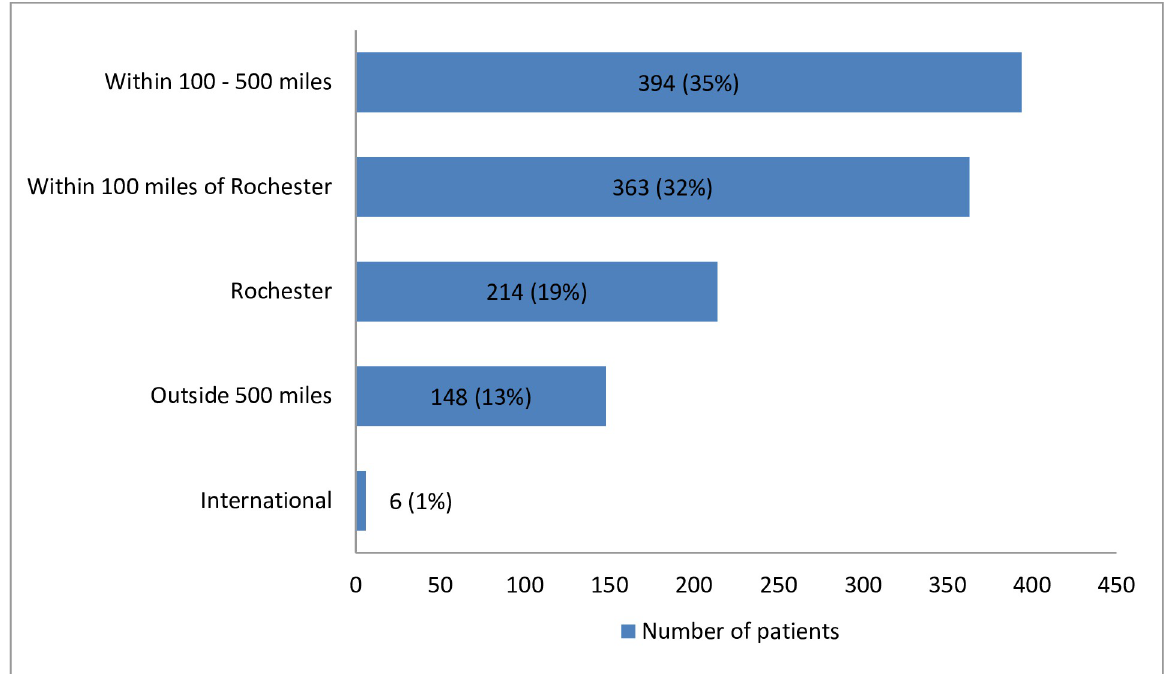
Fig 3. Number and percent of telenephrology visits by geography. The figure graphically represents the plurality of locations served by telenephrology.